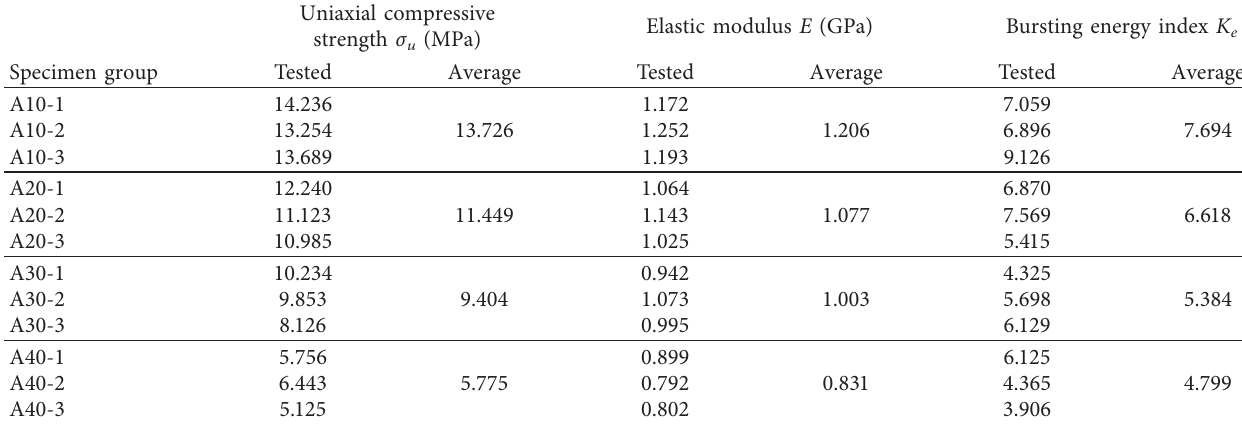
Table 1: Mechanical parameters of composite specimens with different dip